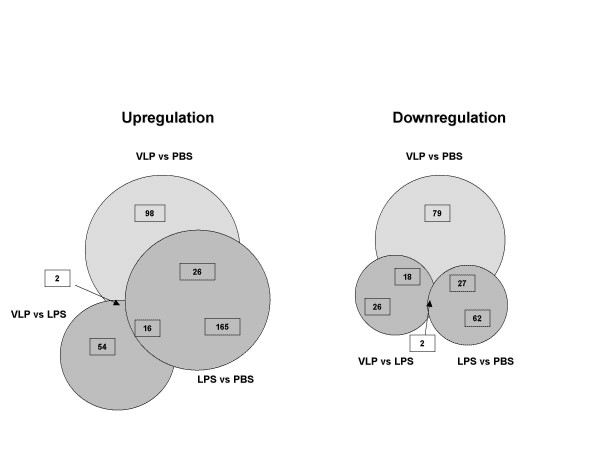
Pattern of gene expression in human monocyte-derived DCs. Regulated genes by HIV-VLPs or LPS treatment in MDDCs, showing at least a 2-fold modulation (up or downregulation), have been evaluated. Each circle represents the whole set of genes identified in the indicated comparisons, based on the 2-fold modulation parameter. Numbers in overlapping regions represent common regulated genes. Numbers in non-overlapping regions represent unique regulated genes. Circles are drawn in arbitrary scale.